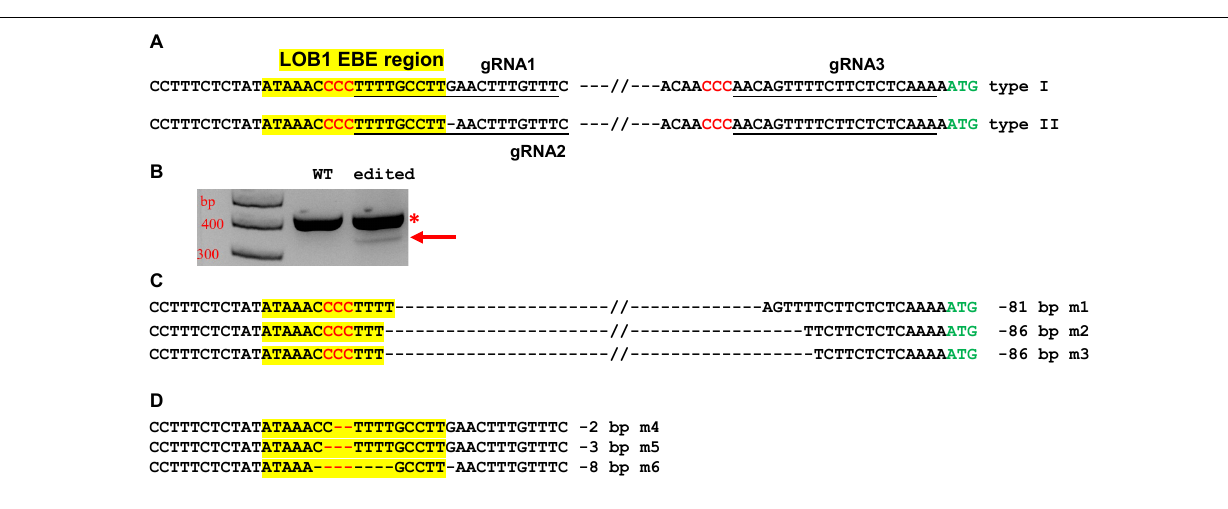
found. Hence, it is very likely that there are no